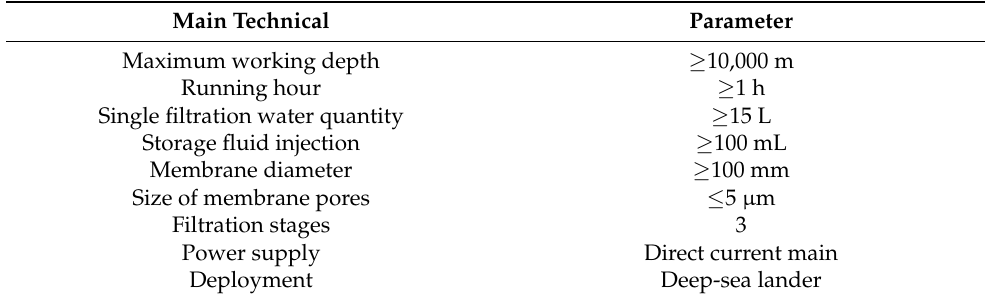
Figure 1. The in situ multi-stage filtering and preserving device. Table 1. Main technical indexes of in situ multi-stage filtering and preserving device for hadal microorganisms.